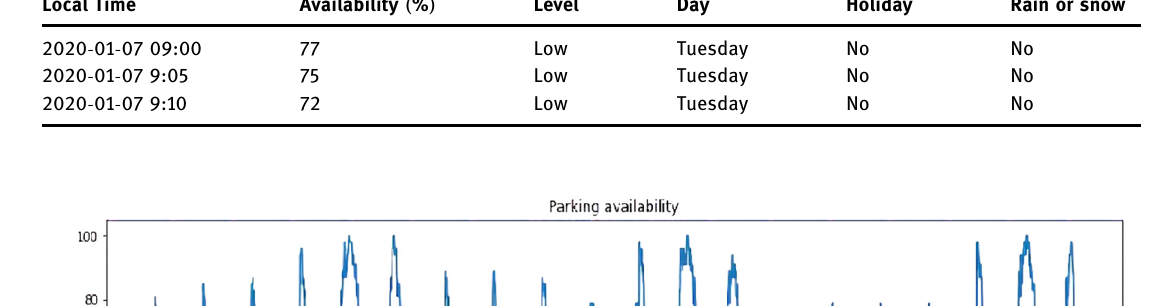
Table 2: Example of time series input data for the model Local Time